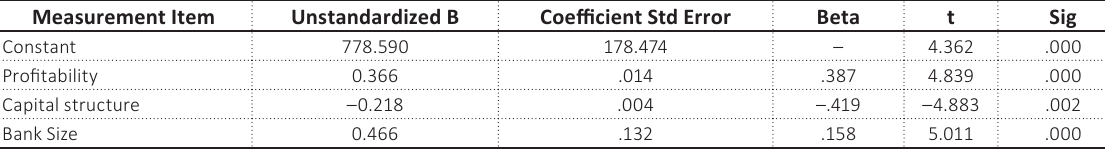
Table 3. Results of data firm value as a dependent